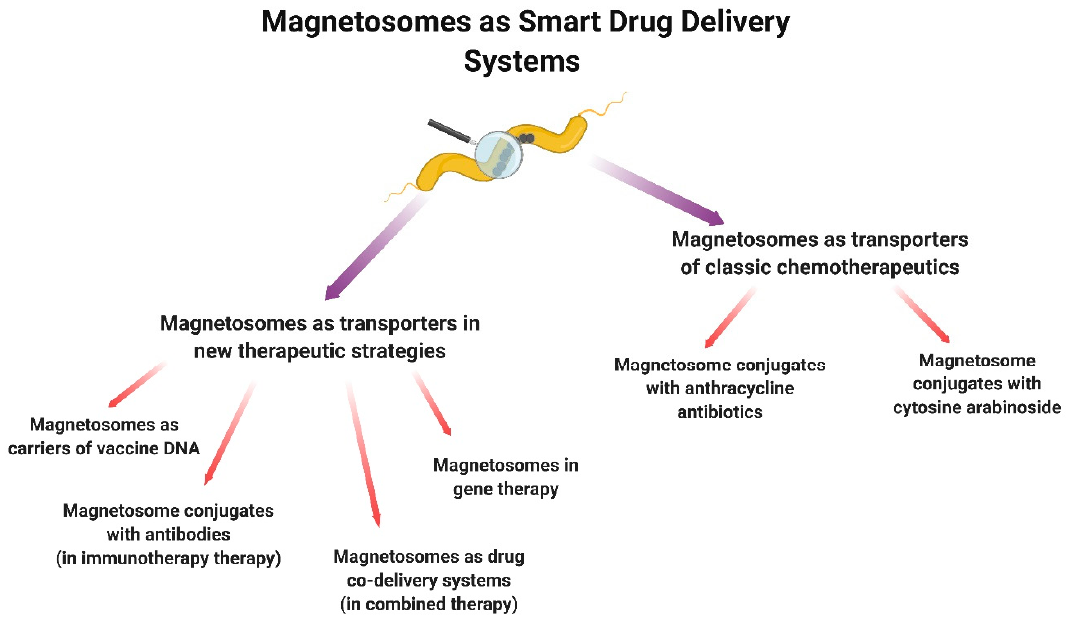
Figure 4. Application of magnetosomes for drug delivery in cancer therapy.